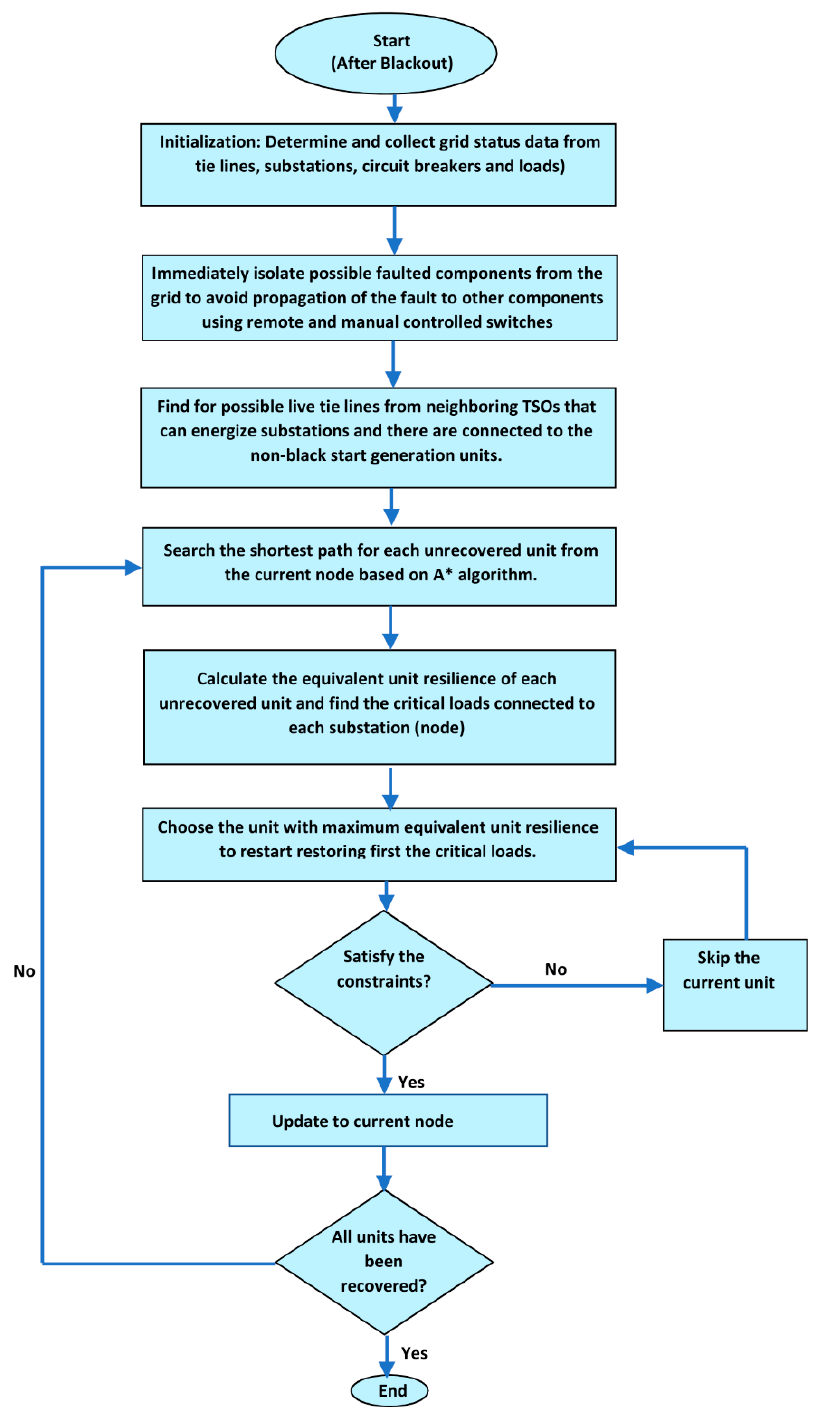
Figure 8. Flowchart of the optimal start-up generator and the tie line sequence